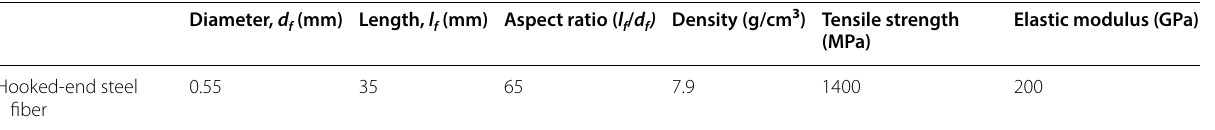
Table 4 Properties of hooked-end steel fibers.